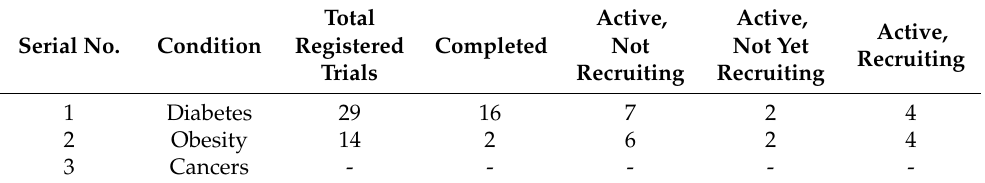
Table 1. Status of tirzepatide administration-related clinical trials. (Search keywords: Dia- betes/Obesity/Cancer + Tirzepatide) (https://clinicaltrials.gov/ (accessed on 12 October 2022).